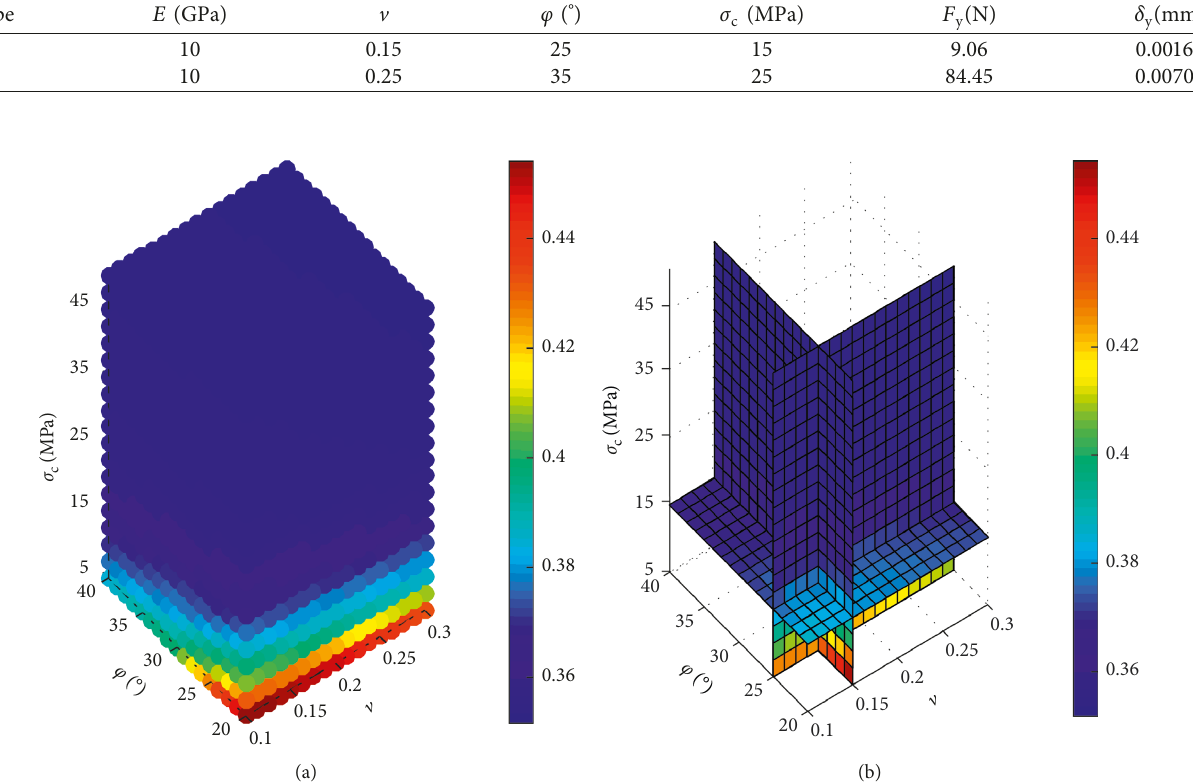
Figure 7: Interpolation of the loading coefficient a for E